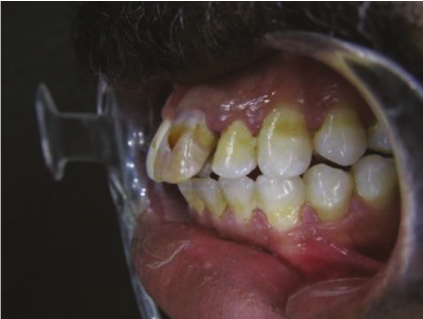
Figure 3: Case 1: proclination of upper teeth due to occlusal interference of the tubercles.